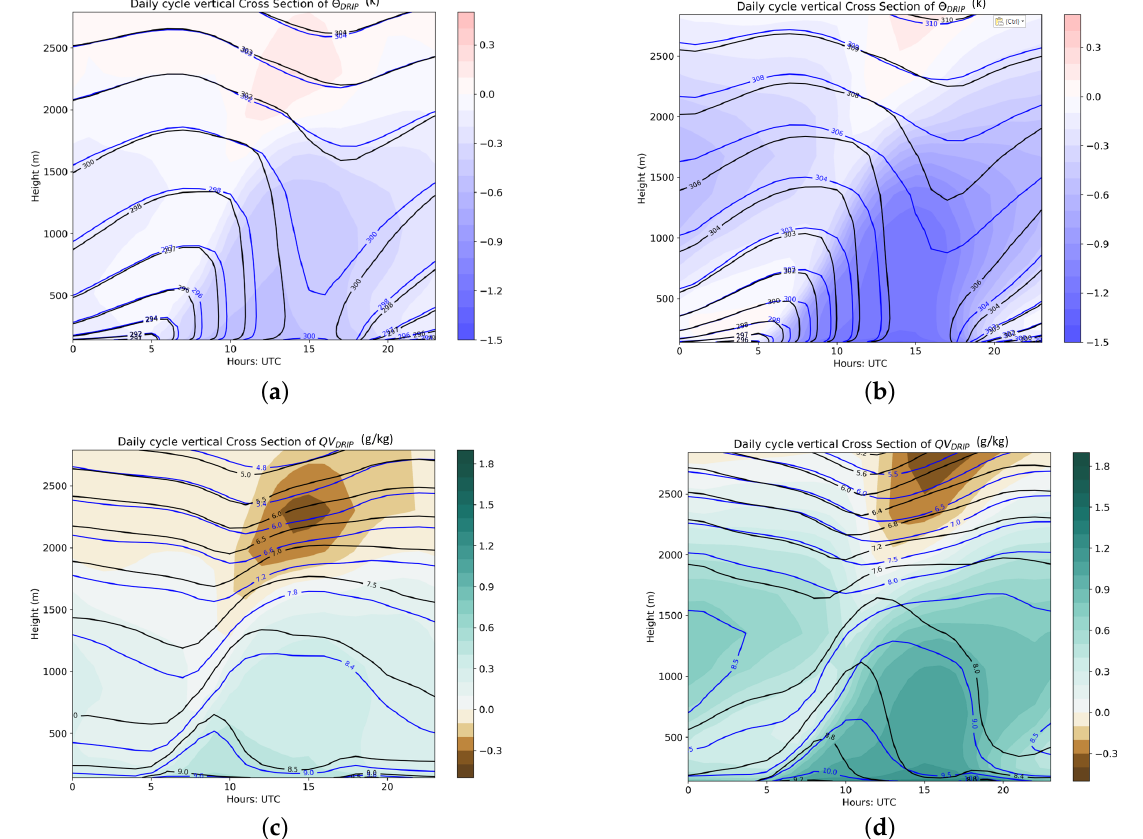
Figure 7. Diurnal cycle for the differences (shaded) between DRIP and CTRL, and their absolute values (respectively blue and black line), for the potential temperature ( Θ , upper panel) and moisture content (QV, lower panel) in the lower atmosphere. Both June (left side) and July (right side) are shown. ( a ) Potential temperature for June 2015. ( b ) Potential temperature for July 2015. ( c ) Atmospheric moisture content for June 2015. ( d ) Atmospheric moisture content for July